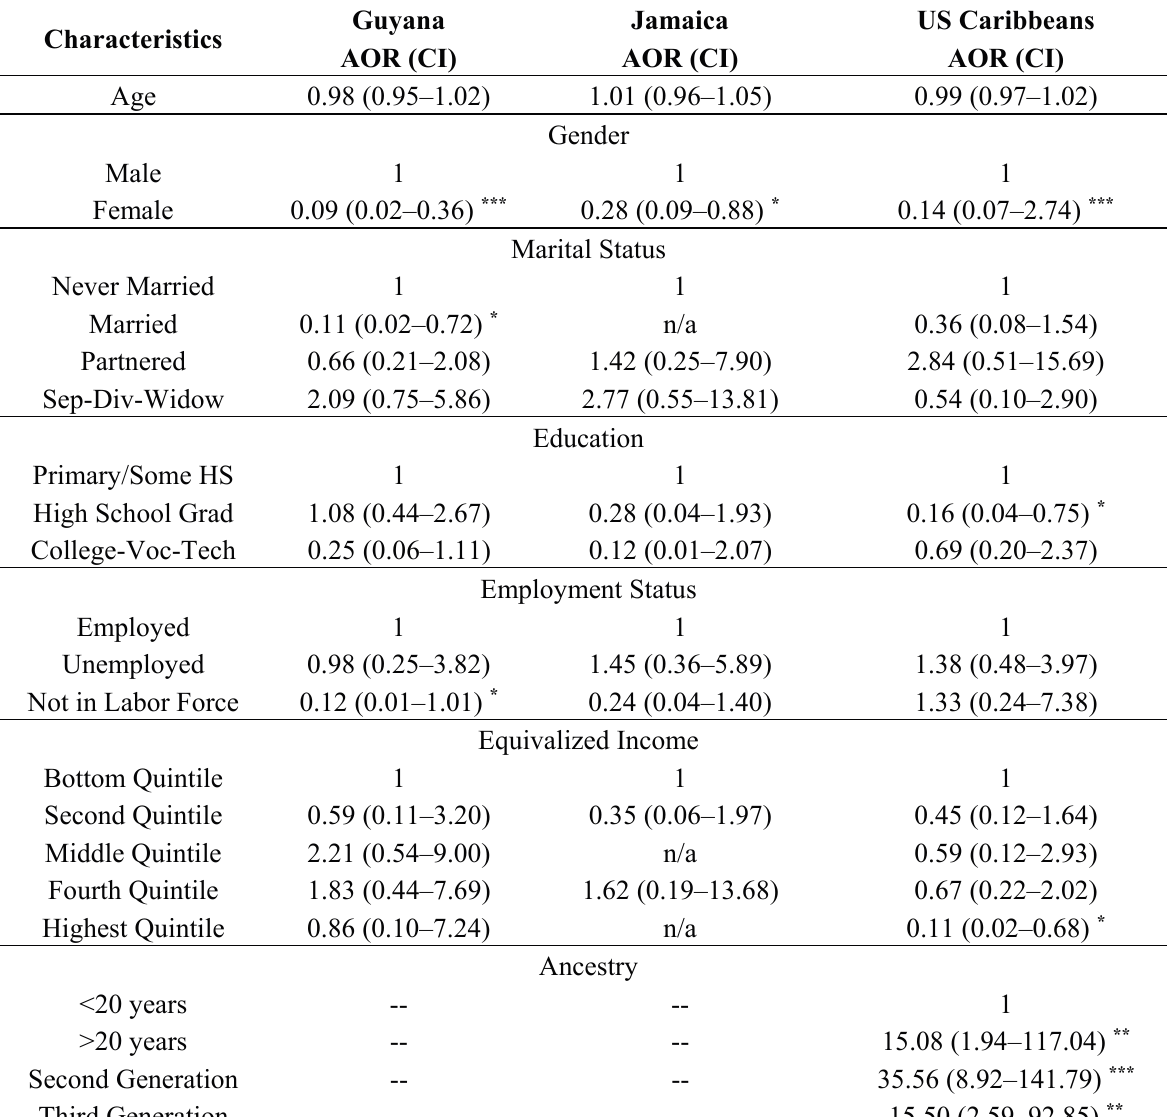
Table 3. Factors associated with lifetime prevalence of drug abuse by